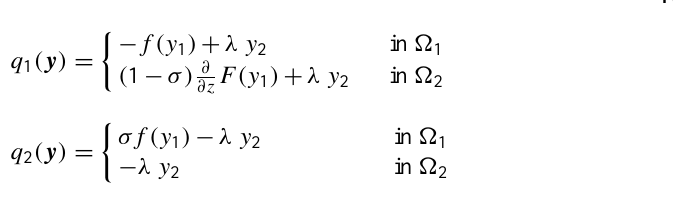
Table 2. Parameters in the N-DOP